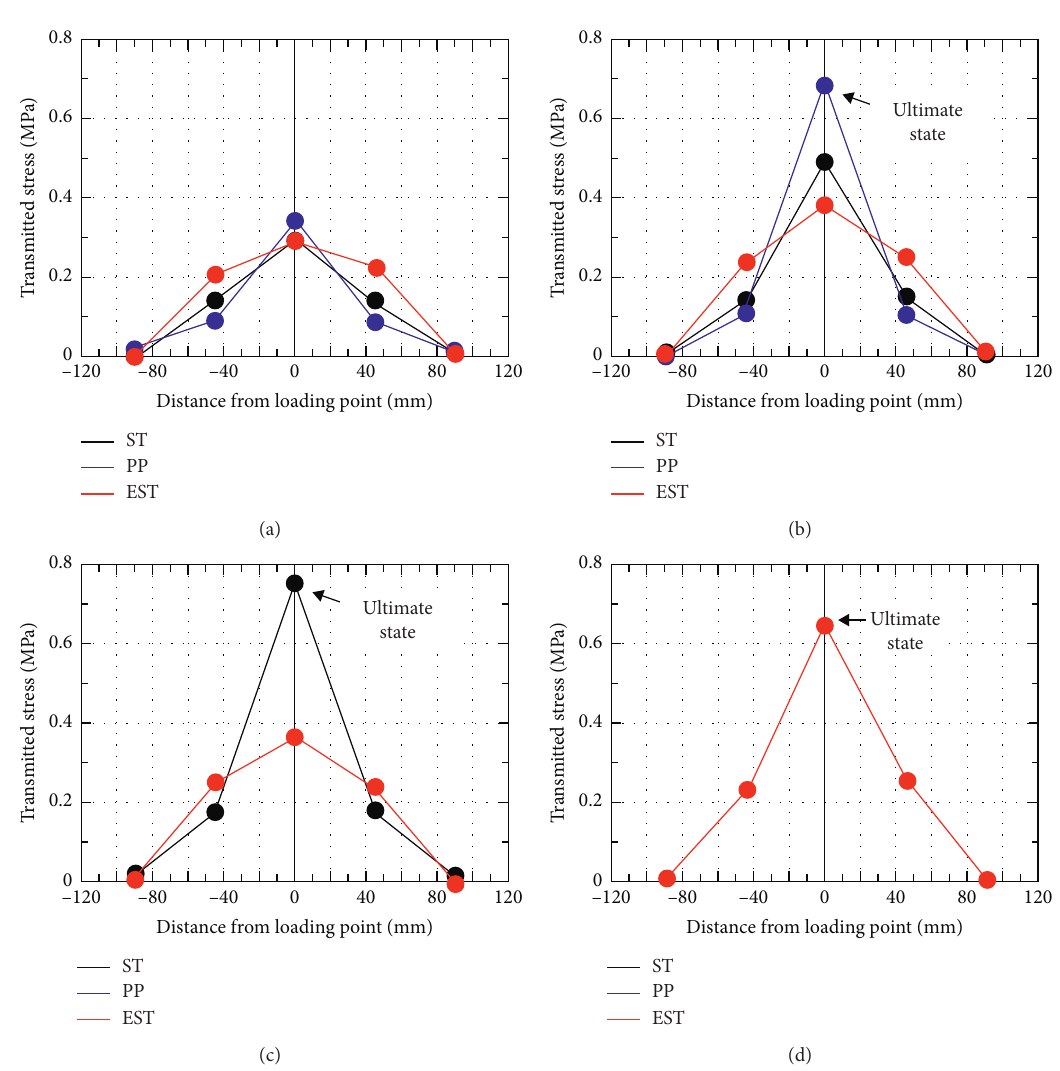
Figure 10: Transmission impact stress distribution at the maximum penetration in the case without core slabs. (a) H � 100mm. (b) H � 150mm. (c) H � 200 mm. (d) H �